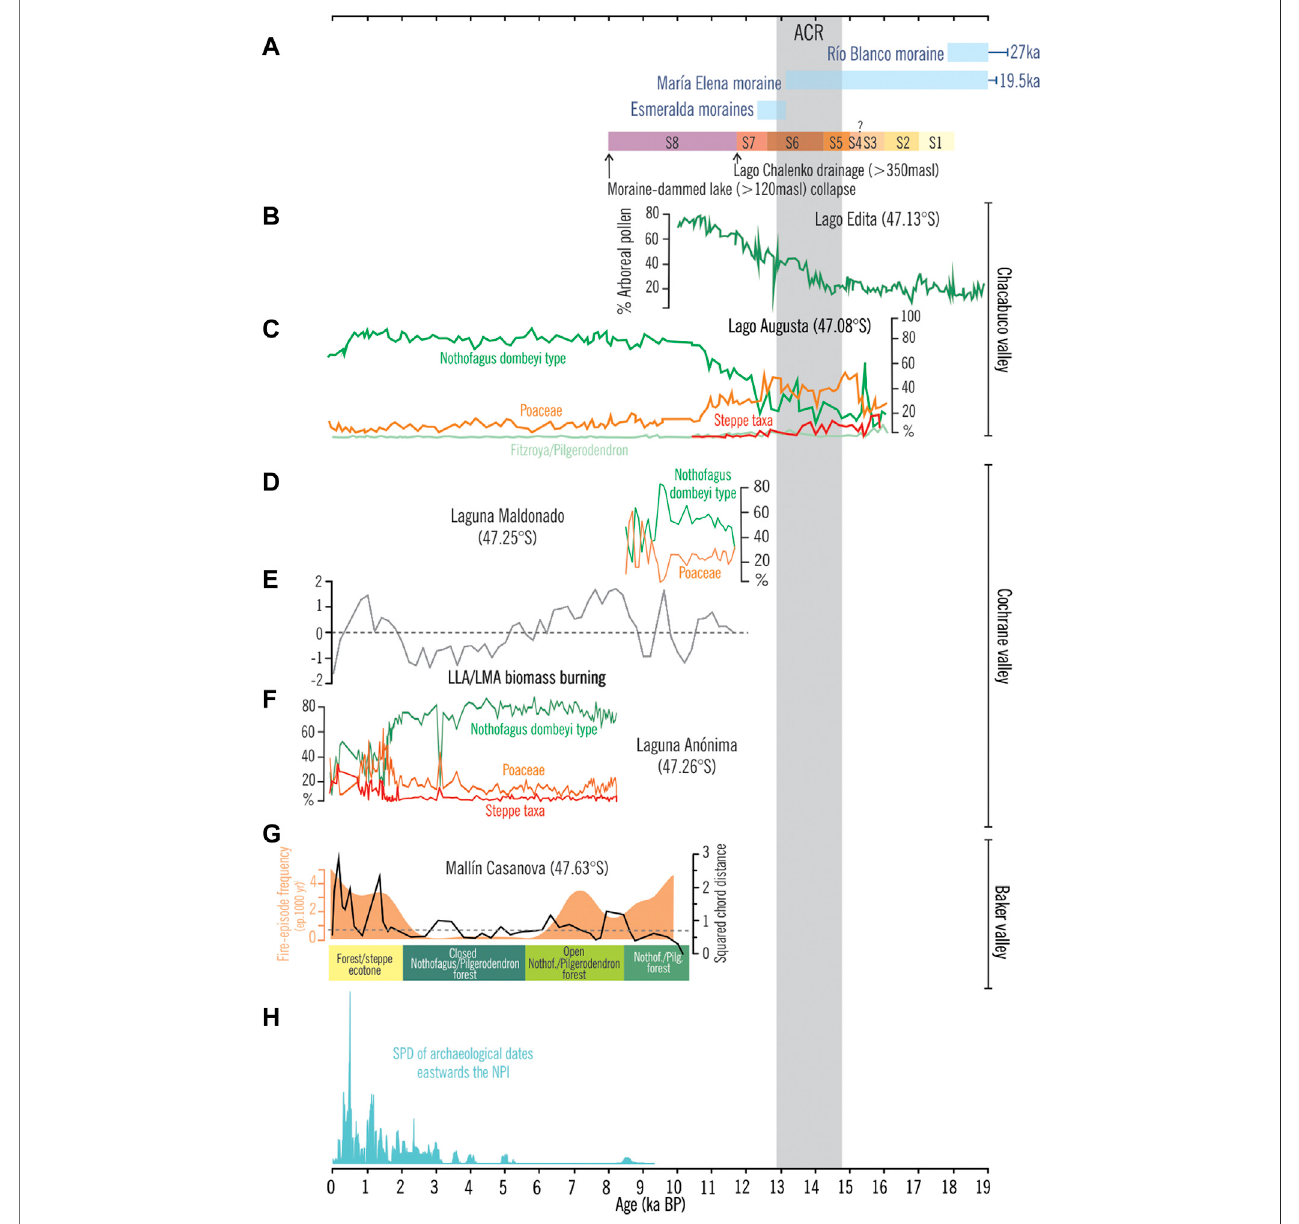
FIGURE 6 | Integration of selected paleoenvironmental data from CWP since the LGM showing (A) the chronology of the Chacabuco and Lago Cochrane/ Pueyrredón main moraines and the deglaciation stages of Lago Buenos Aires/General Carrera and Lago Cochrane/Pueyrredón proposed by Hein et al., 2009, 2010; Villa-Martínez et al., 2012; Boex et al., 2013; Turner et al., 2005; Glasser et al., 2012; Davies et al., 2018, 2020; Thorndycraft et al., 2019; (B) Lago Edita arboreal pollen percentages (Henríquez et al., 2017); (C) Lago Augusta summarized pollen diagram (Villa-Martínez et al., 2012); (D) a summarized pollen diagram (%) of Laguna Maldonado; (E) raw composite charcoal series as a proxy of biomass burning from LMA and LLA; (F) a summarized pollen diagram (%) of Laguna Anónima; (G) Mallín Casanova vegetation changes, fi re-episode frequency, and square chord distance as a proxy of vegetation change magnitude (Iglesias et al., 2018); (H) summed probability distribution curve of archeological 14 C ages from the eastern side of the NPI (Nuevo Delaunay et al., 2022).